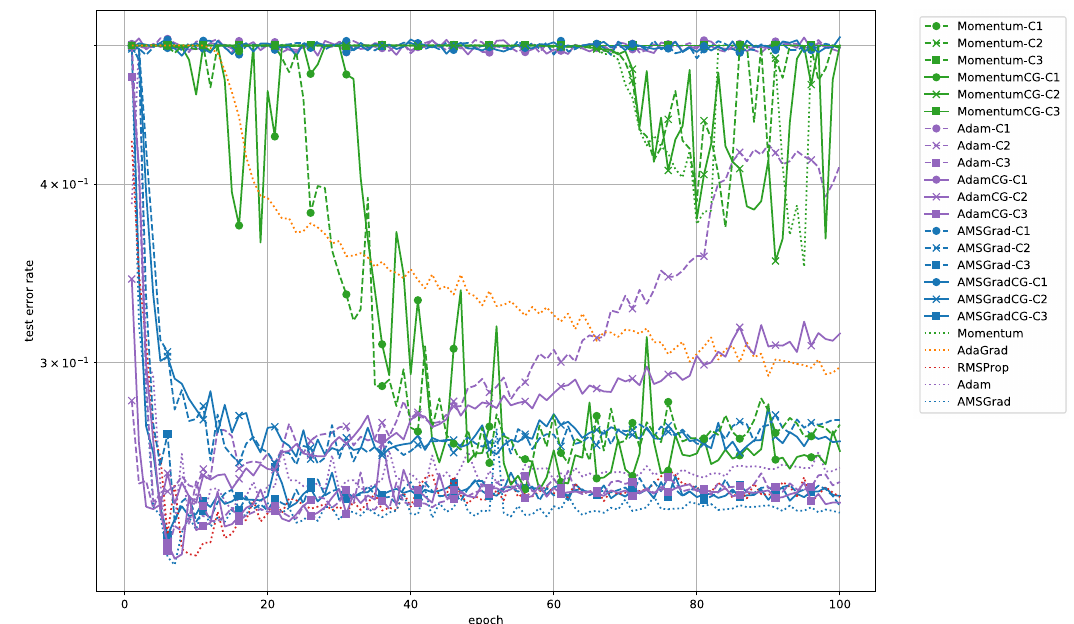
Figure 9. Classification error rate versus number of epochs on the IMDb dataset for testing (constant).